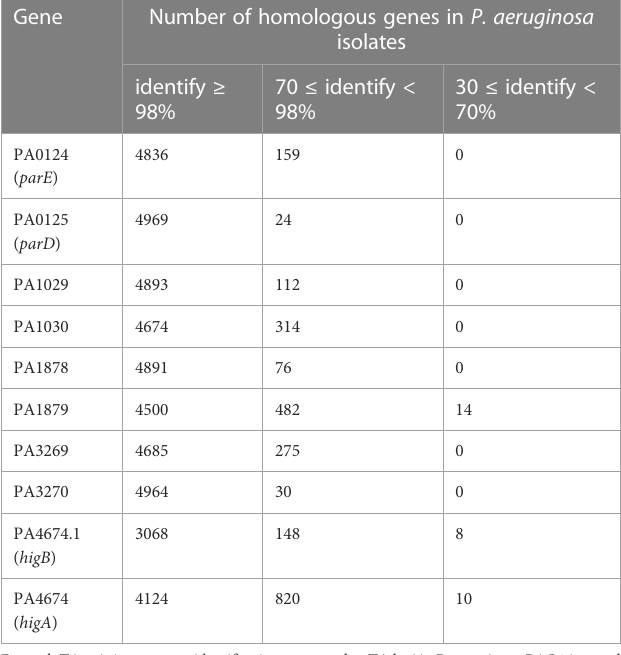
TABLE 1 Screening genes homologous to type II TA of P. aeruginosa PAO1 among 4955 P . aeruginosa clinical isolates. Gene Number of homologous genes in P. aeruginosa